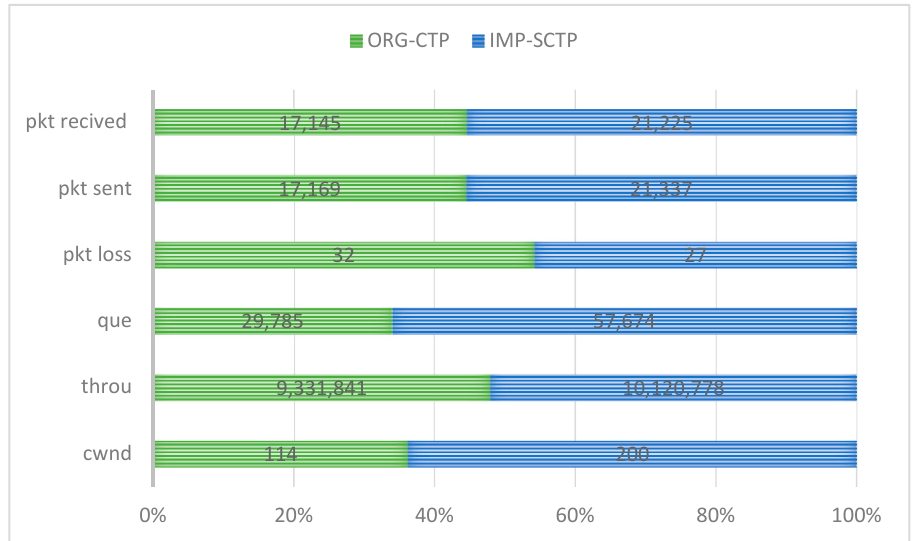
Figure 11. ORG-SCTP versus IMP-SCTP.